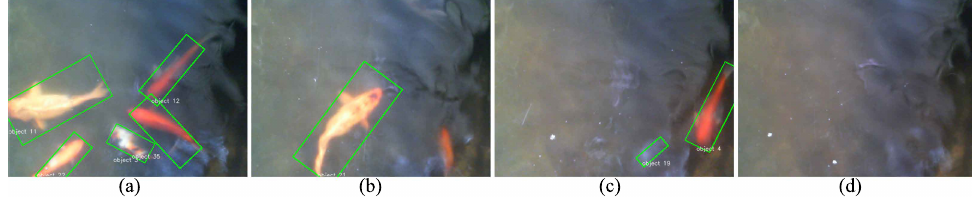
Figure 12. The categories of each type. From left to right: ( a ) True Positive (TP), ( b ) False Negative (FN), ( c ) False Positive (FP), ( d ) True Negative